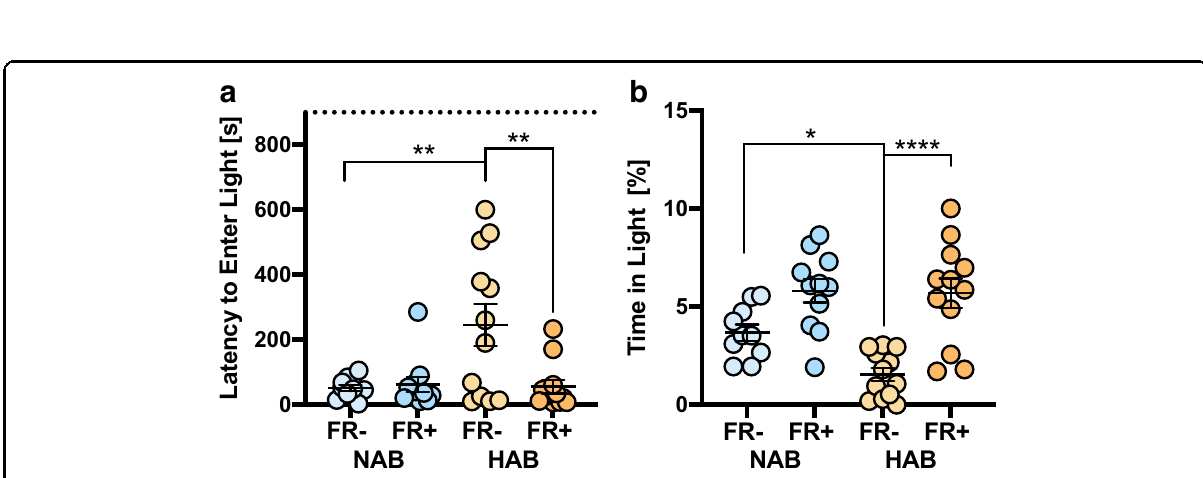
Fig. 2 Elevated plus maze (EPM). a – f Behavioral performance of food-restricted (FR + ) and ad libitum-fed (FR − ) HAB and NAB mice during a 15-min exposure to the EPM. SAP stretch-attend postures. For further details, see Fig. 1.